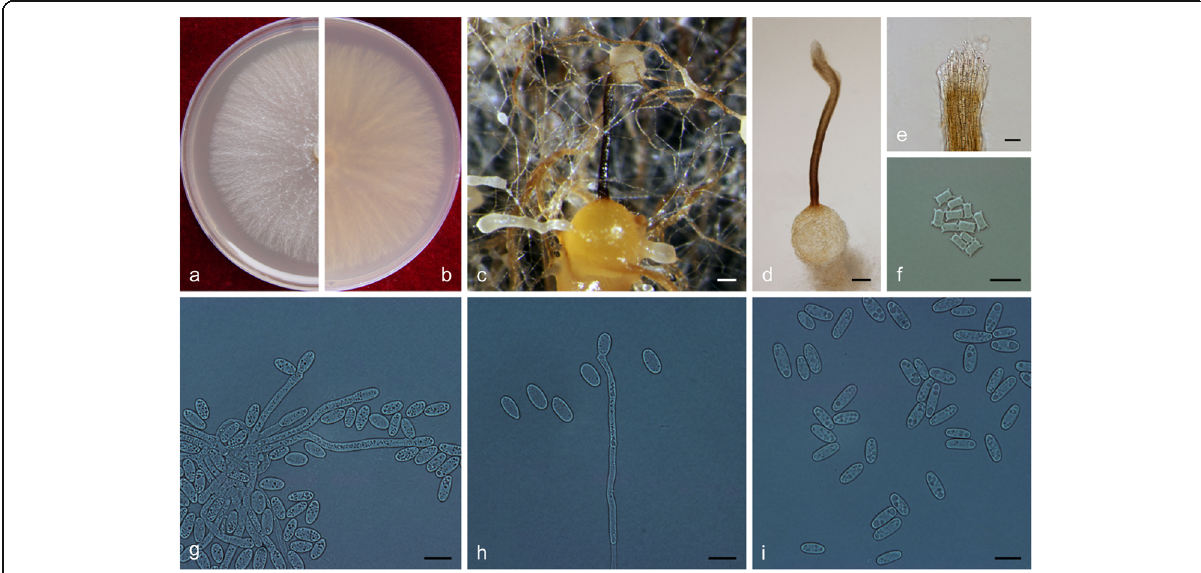
Fig. 17 Morphological characteristics of Ophiostoma pseudobicolor sp. nov. (CFCC 52683, Taxon 8). a – b . Five-day-old cultures on 2% MEA; c – d . Perithecium. e . Apex of perithecium. f . Ascospores. g – i . Hyalorhinocladiella-like asexual morph: conidiogenous cells and conidia. Scale bars: c – d = 100 μ m; e = 20 μ m; f – i = 10 μ